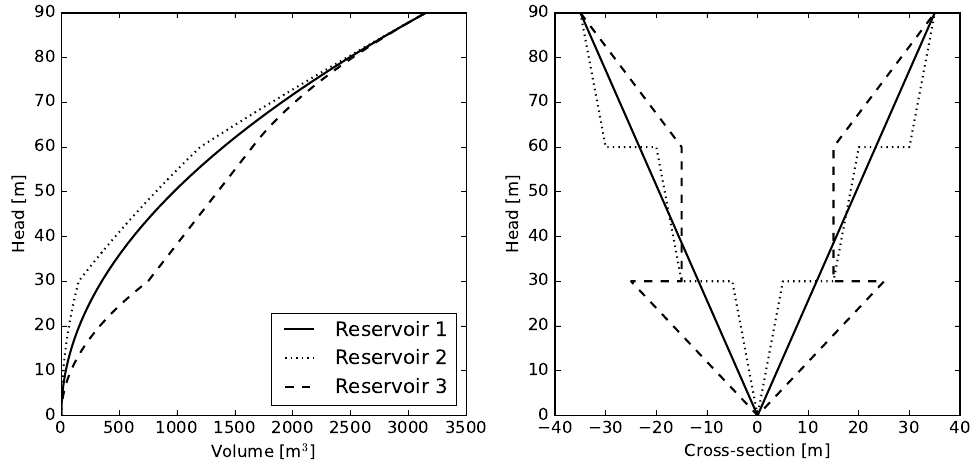
Figure 2. ( Right ) Cross-section of some artificial hydropower reservoirs. ( Left ) Head as a function of reservoir volume for the same reservoirs (corresponding line style). It is assumed that, from the view of the cross-section, the reservoirs has a depth of one